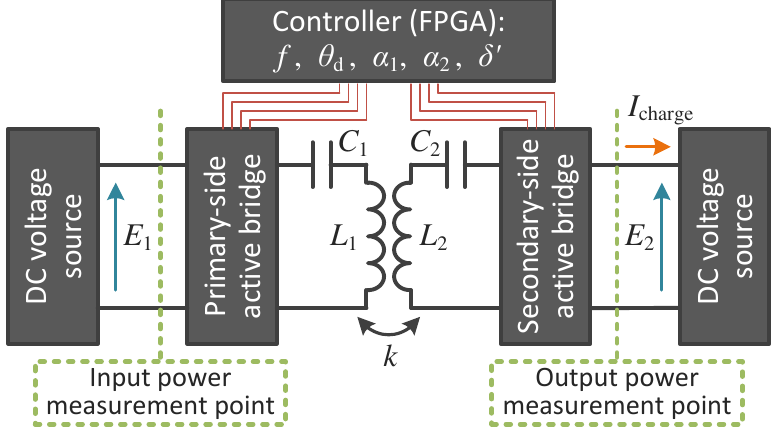
Figure 8. Overview of the experimental